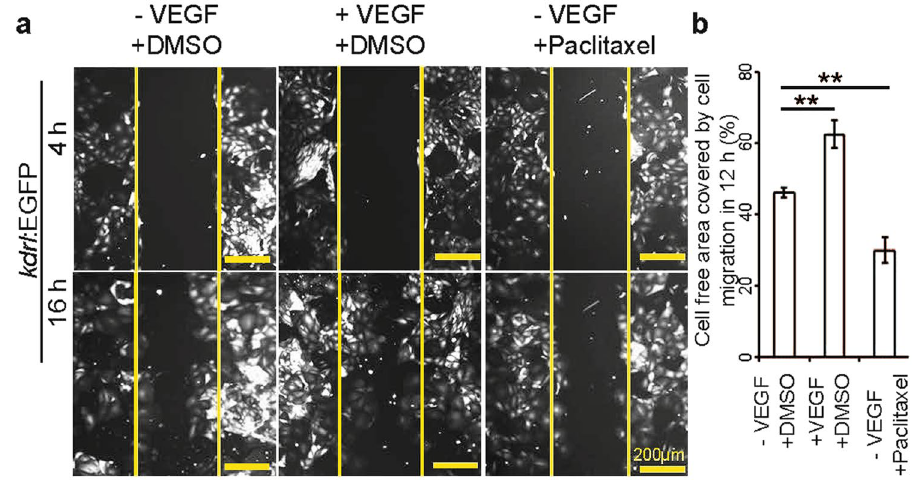
Figure 7. The migratory behavior of cardiac endothelial cells can be regulated by small molecule and growth factor treatment. ( a ) Fluorescence images at 4 and 16 h after scratching in the presence or absence of VEGF or Paclitaxel as indicated. ( b ) Quantitative analysis of the relative cell free area covered by endothelial cell migration in 12 h. Control cells were treated with DMSO, and in all cases, cell free area at 4 h after scratch was considered as 100% (n = 3, mean ± SEM). One way ANOVA followed by Bonferroni’s post-hoc test (GraphPad Prism) was performed to evaluate statistical significance of differences. P < 0.05 was considered statistically significant. ** corresponds to P <